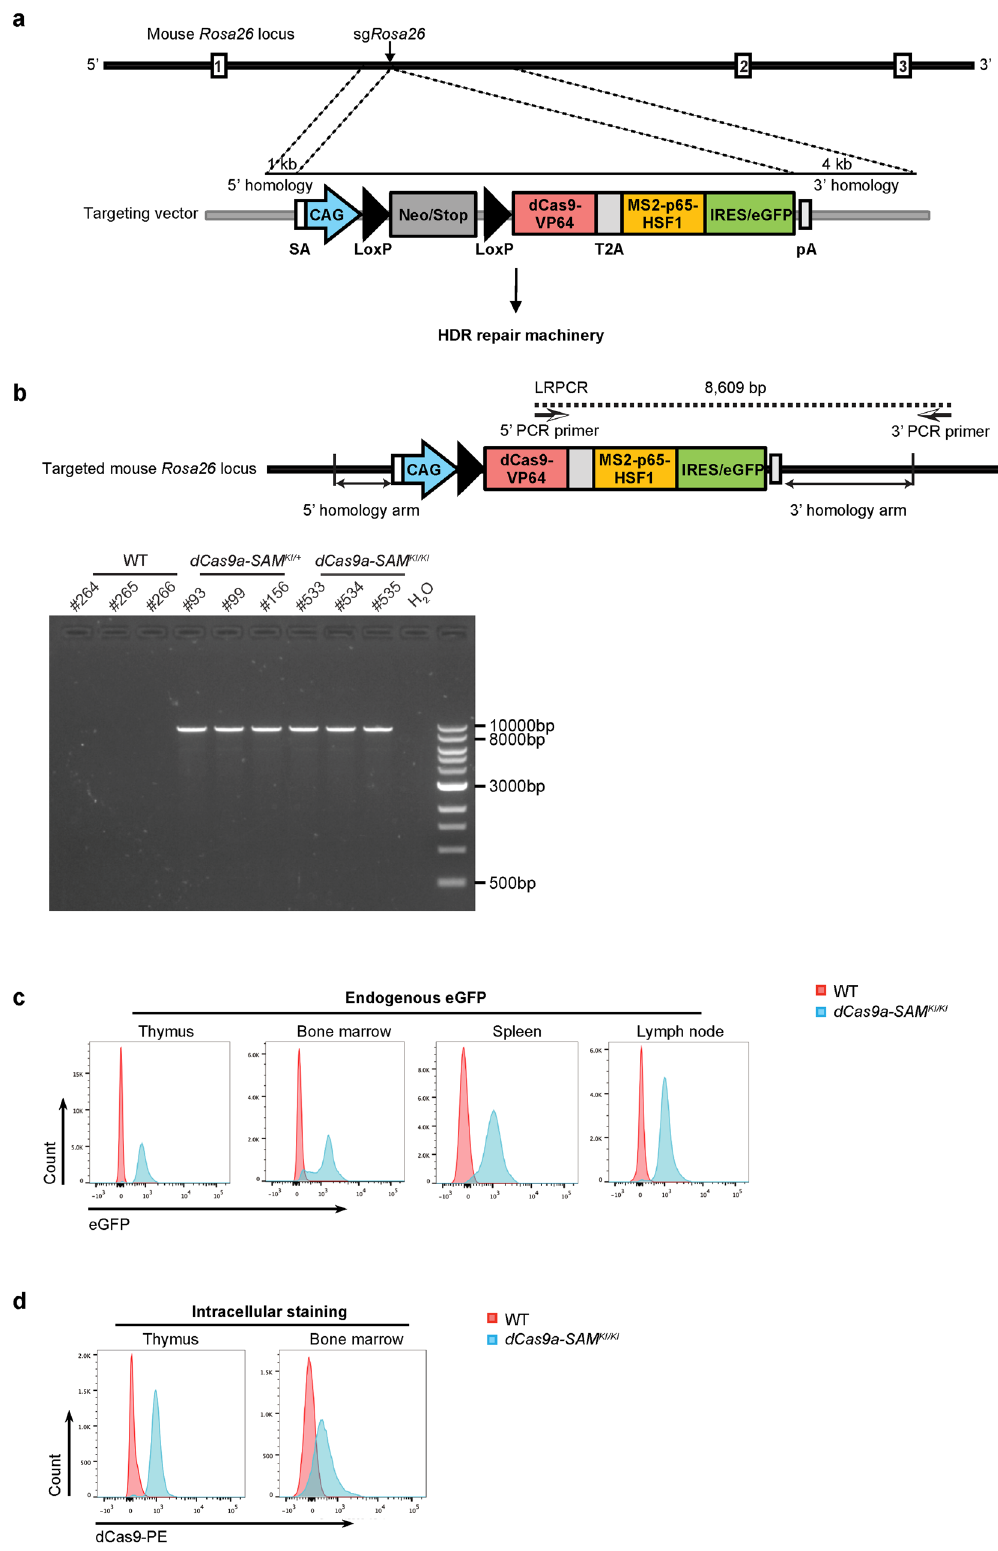
Fig. 2 | Establishment and validation of dCas9a-SAM KI/KI mice. a Strategy for targeting of the dCas9a-SAM cassette into the mouse Rosa26 locus using CRISPR/ Cas9 technology. Repair of the DNA cut by endogenous homology-directed repair (HDR)mechanismusinghomologysequencespresentinthepRosa26-dCas9a-SAM vector enables the insertion of the dCas9a-SAM cassette into the Rosa26 locus. b Long range PCR (LR – PCR) based validation of dCas9 expression in dCas9a-SAM